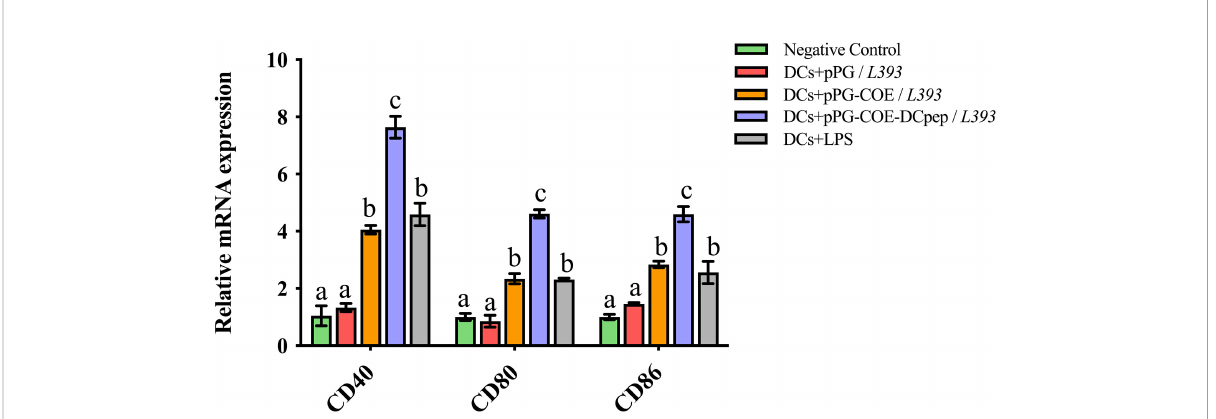
FIGURE 4 Marker expression of Mo-DCs (10 6 cells/ mL) stimulated by pPG/ L393 , pPG-COE/ L393 , pPG-COE-DCpep/ L393 , and LPS (2 µg/mL) assessed by relative qRT-PCR, recombinant Lactobacillus -incubated DCs at a ratio of 1:10 (DCs:recombinant Lactobacillus ). Different letters (a vs. b, a vs. c, b vs. c) indicate signi fi cant differences (p < 0.01) at the same time